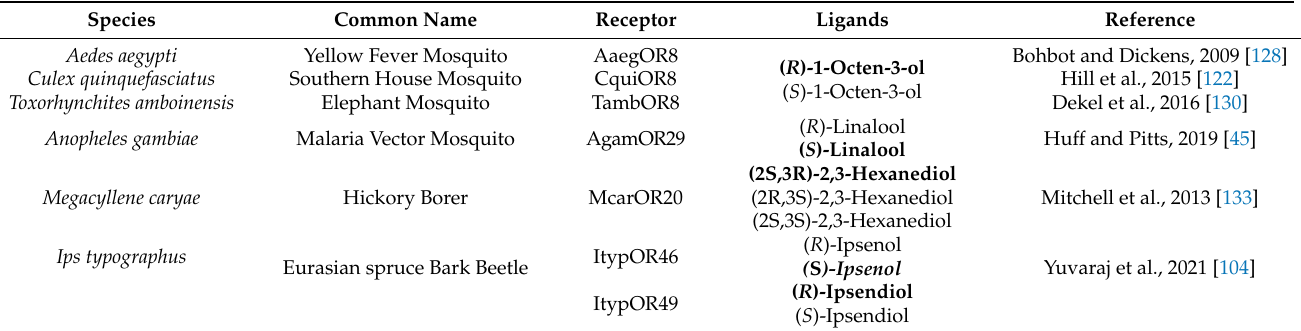
Figure 8. The chemical structures of A. aegypti kairomone ( R )-1-octen-3-ol 27 and ( S )-1-octen-3-ol 28 , the pheromone components ( S )-ipsenol 29 , ( R )-ipsenol 30 , ( R )-ipsdienol 31 and ( S )-ipsdienol 32 of the Eurasian spruce bark beetle, Ips typographus and the pheromone components ( S )-2-methyl-1-butanol 33 , ( R )-2-methyl-1-butanol 34 , ( 2R,3R )-2,3,-hexanediol 35 , (2 R ,3 S )-2,3-hexanediol 36 , (2 S ,3 R )-2,3- hexandiol 37 and (2 S ,3 S )-2,3-hexandiol 38 of the cerambycid beetle Megacyllene caryae . Table 1. Insect odorant receptors that possess enantioselectivity experimentally. The suggested active enantiomer is highlighted in bold for each